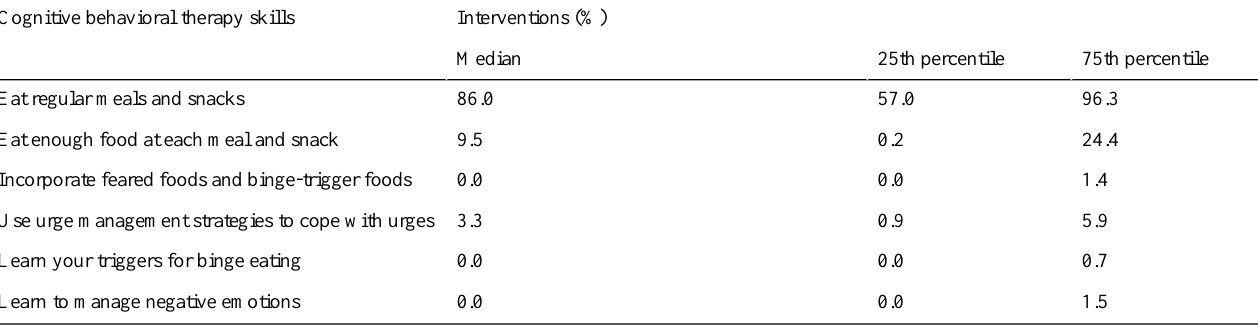
Table 1. The average percentage of total interventions associated with each skill.